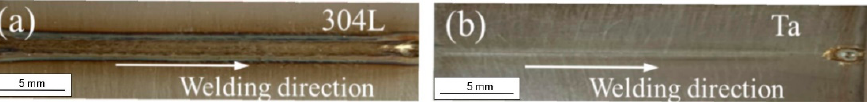
Figure 4. Weld macroscopic morphology of 304L ( a ) and Ta ( b ).